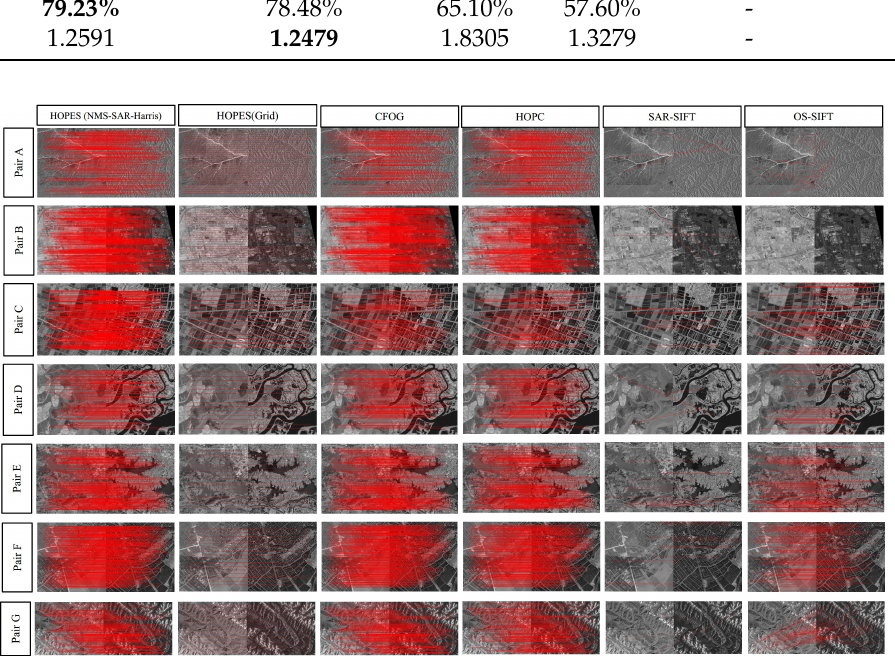
Figure 17. Co-registration results of Pair A–G. Our HOPES achieves the best CMR in all seven data sets and the best RMSE in six data sets. There is little difference between NMS-SAR-Harris and deviding grids strategy. Two SIFT-like algorithms, SAR-SIFT and OS-SIFT, achieved the worst results. As a co- registration algorithm designed for SAR images, SAR-SIFT is difficult to complete the co-registration between optical and SAR in the most cases. OS-SIFT improves the gradient extraction in SAR-SIFT, making it more competent for optical and SAR co-registration. It can complete the co-registration in the textured scenes such as lakes and ponds, but the registration accuracy is not high. At the same time, both algorithms are